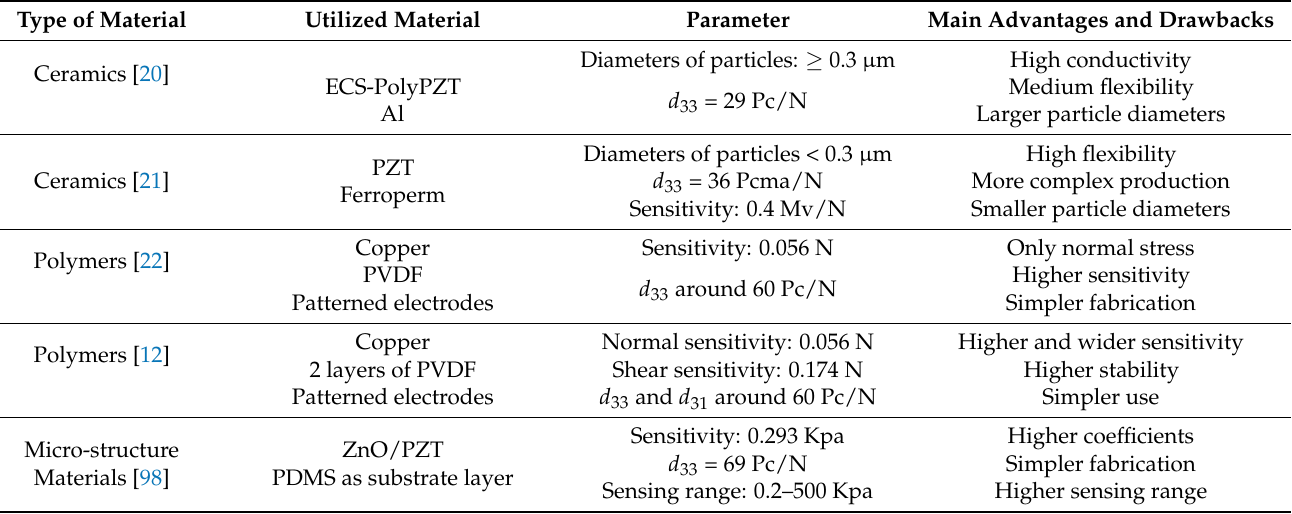
Table 2. Brief description of sensors in Section 3.2. Piezoelectric ceramics have larger particle diameters and sizes, but their stretchability and sensitivity need to be improved. Piezoelectric polymers have higher stretchability and stronger ability to detect shear